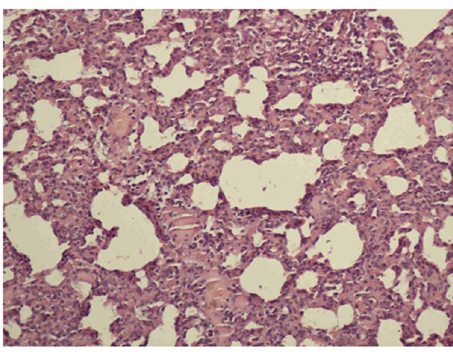
Figure 3. HE stain of PQ group ( 6 200). The inflammatory process with marked infiltration of leukocytes into interstitial and alveolar spaces, edema, alveolar distortion, and thickening of the alveolar wall.